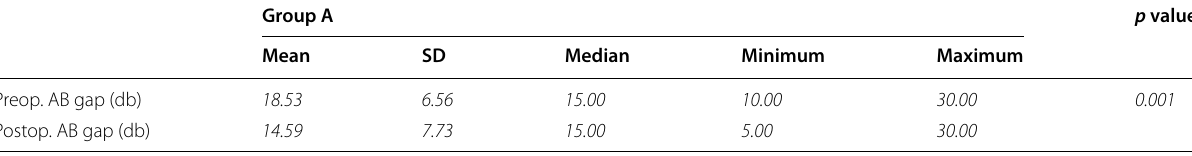
Table 2 Comparison between preop. and postop. AB gap in group A Group